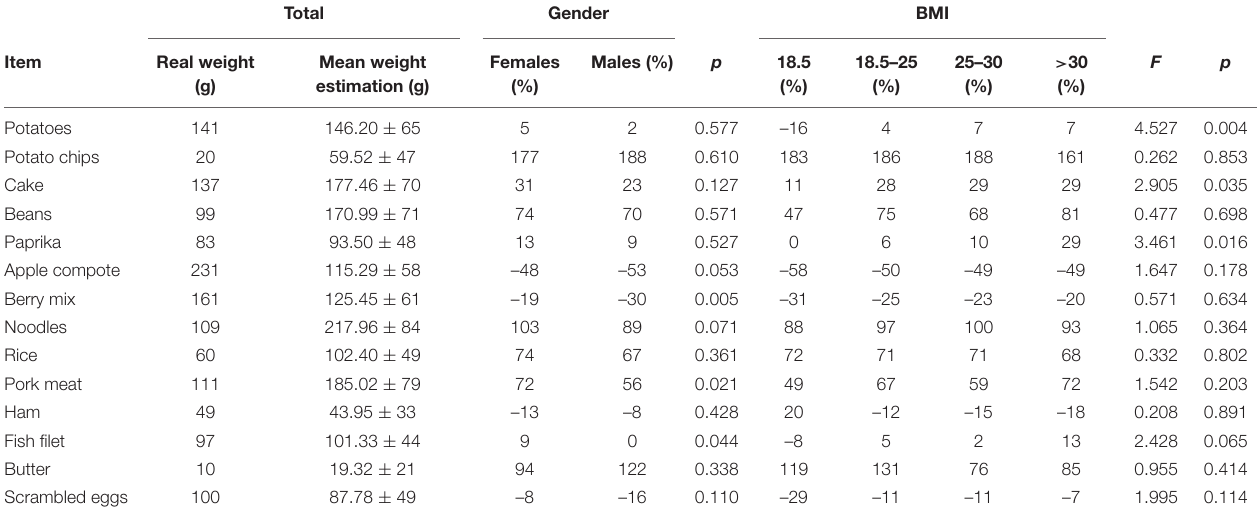
TABLE 1 | Results of study I for gender and BMI